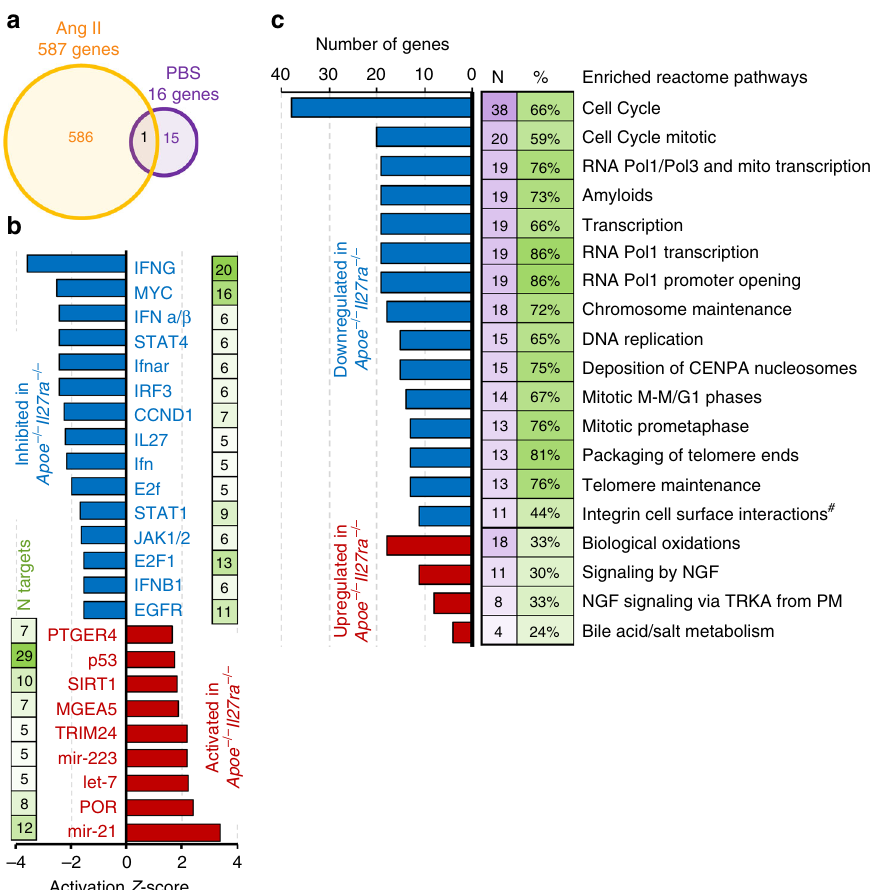
Fig. 6 IL-27R regulates the quiescence of HSCs in Ang II-induced myelopoiesis. LT-HSCs were FACS-sorted from the BM of Apoe − / − ( n = 2), Apoe − / − Il27ra + / − ( n = 4), or Apoe − / − Il27ra − / − ( n = 3) mice fed with WD for 12 weeks and infused with Ang II or PBS for last 2 weeks of feeding, and subjected to whole transcriptome analysis (RNA-seq). a Overall number of genes whose expression is changed between Apoe − / − and Apoe − / − Il27ra − / − mice either treated with Ang II (587 genes) or with PBS (control, 16 genes). b Deregulated upstream regulators whose targets were signi fi cantly overrepresented ( p <0.05, Fisher ’ s exact test) among genes uniquely affected by genetic IL-27R de fi ciency. c Various pathways signi fi cantly deregulated ( p <0.05, GSEA) by IL-27R de fi ciency, as determined by Reactome pathway enrichment analysis. Changed pathways include cell cycle, proliferation, and division in LT-HCS after Ang II infusion ( # p = 0.056,